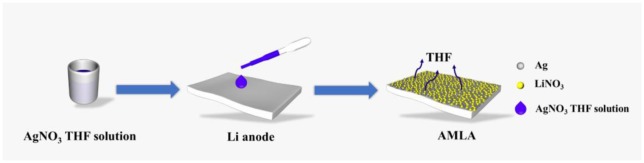
The illustration of the synthesis of the AMLA.